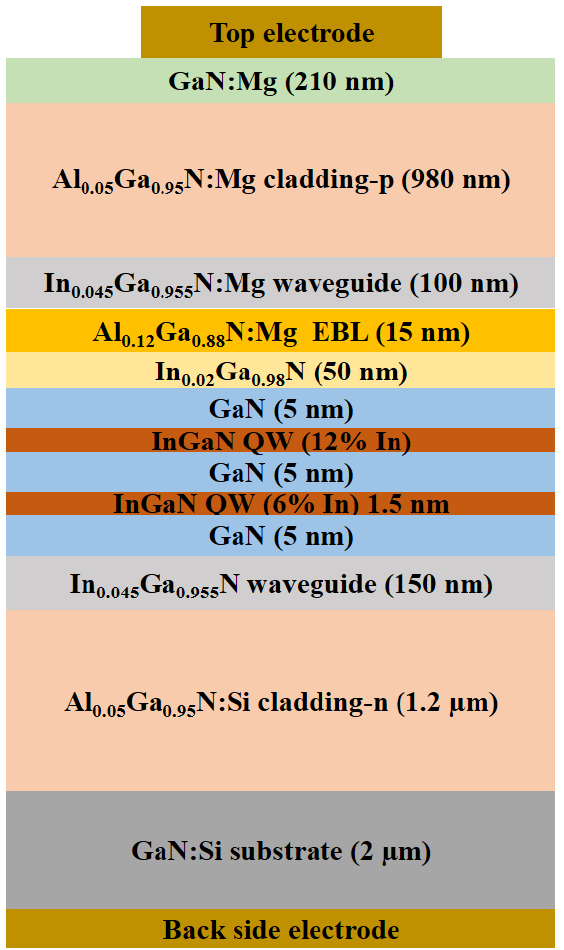
Figure 5. Cross-sectional view of the epitaxial structure of the proposed device design.